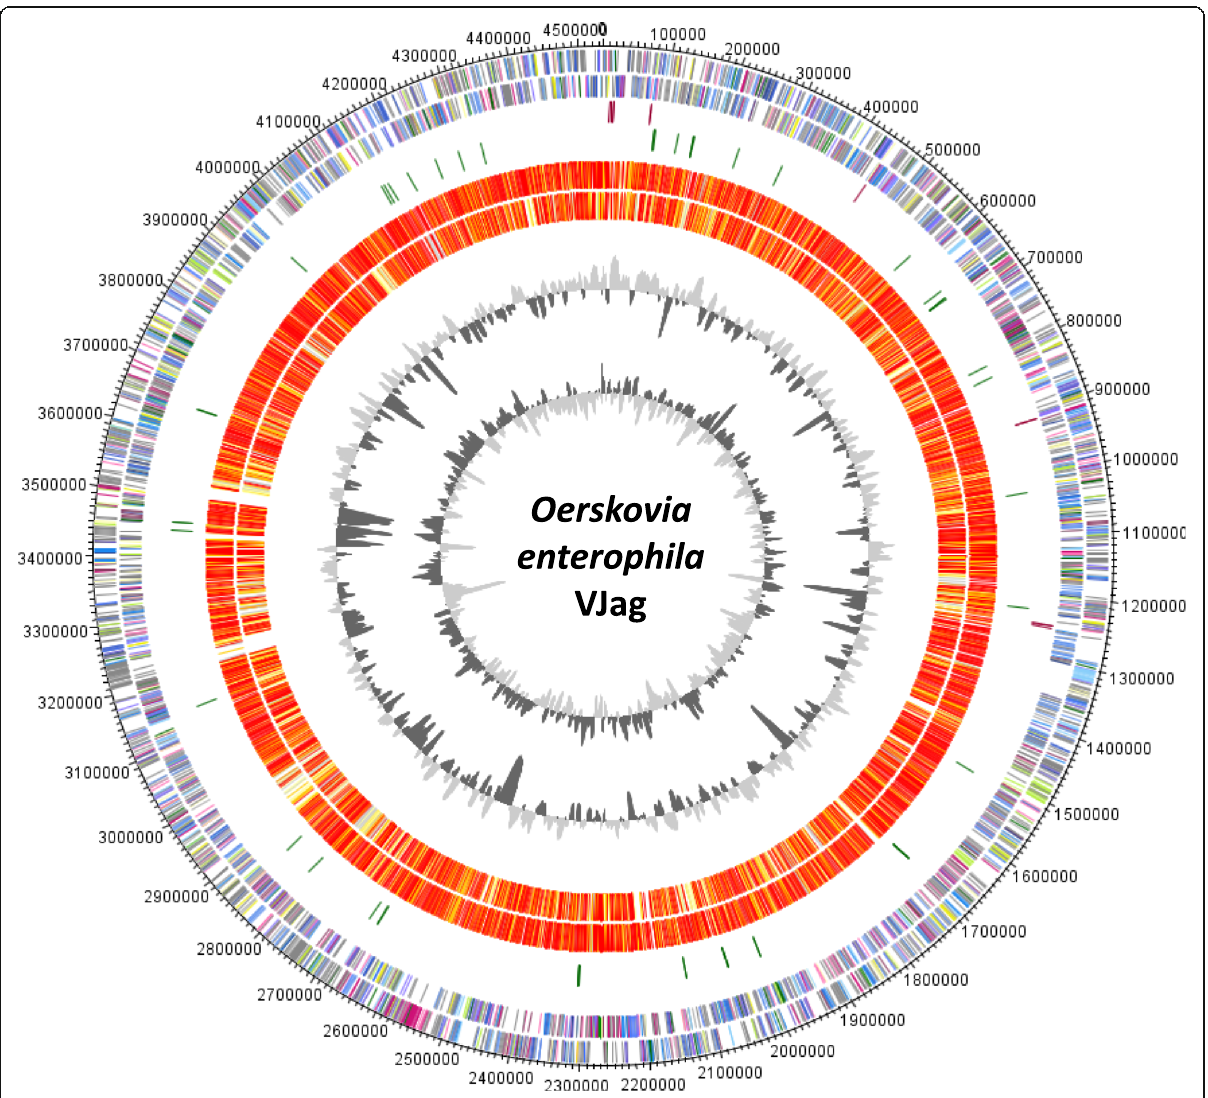
Fig. 3 Circular representation of the genome comparison of O. enterophila VJag with other Oerskovia strains. Outer circles 1 and 2, genes (marked in COG colors) encoded by the leading and the lagging strand of O. enterophila VJag; circles 3 and 4, positions of rRNA and tRNA genes, respectively; circle 5, comparison of genes present in O. enterophila VJag and O. enterophila DFA-19 T ; circle 6, gene comparison of O. enterophila VJag and O. turbata NRRL B-8019; circle 7 represent the GC content circle 8; represent GC skew. Color code of genome comparison: grey : >e -20 -1; light yellow : <e -50 - > e -20 ; gold : <e -50 - >e -90 ; light orange : <e -90 ->e -100 ; orange : <e -100 ->e -120 ; red : <e